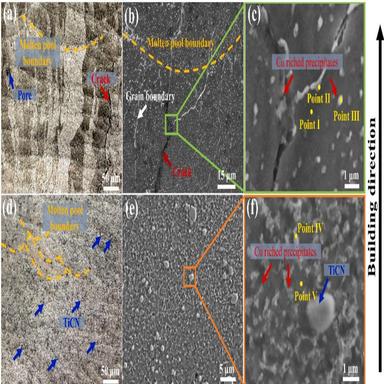
OM and SEM microstructure of (a–c) pure 2024 Al alloy, and (d–f) 2024-5 vol% TiCN composite.